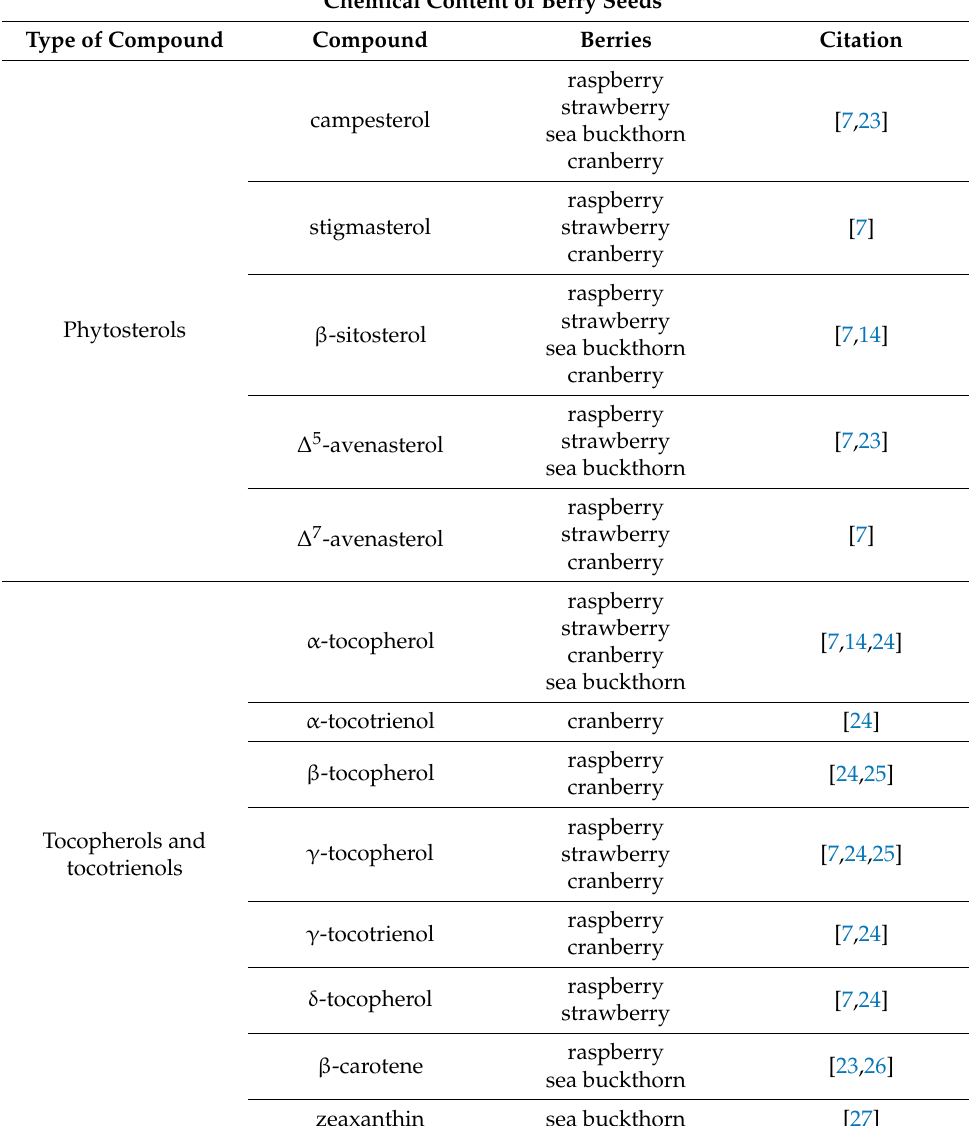
Table 1. Chemical content of berry